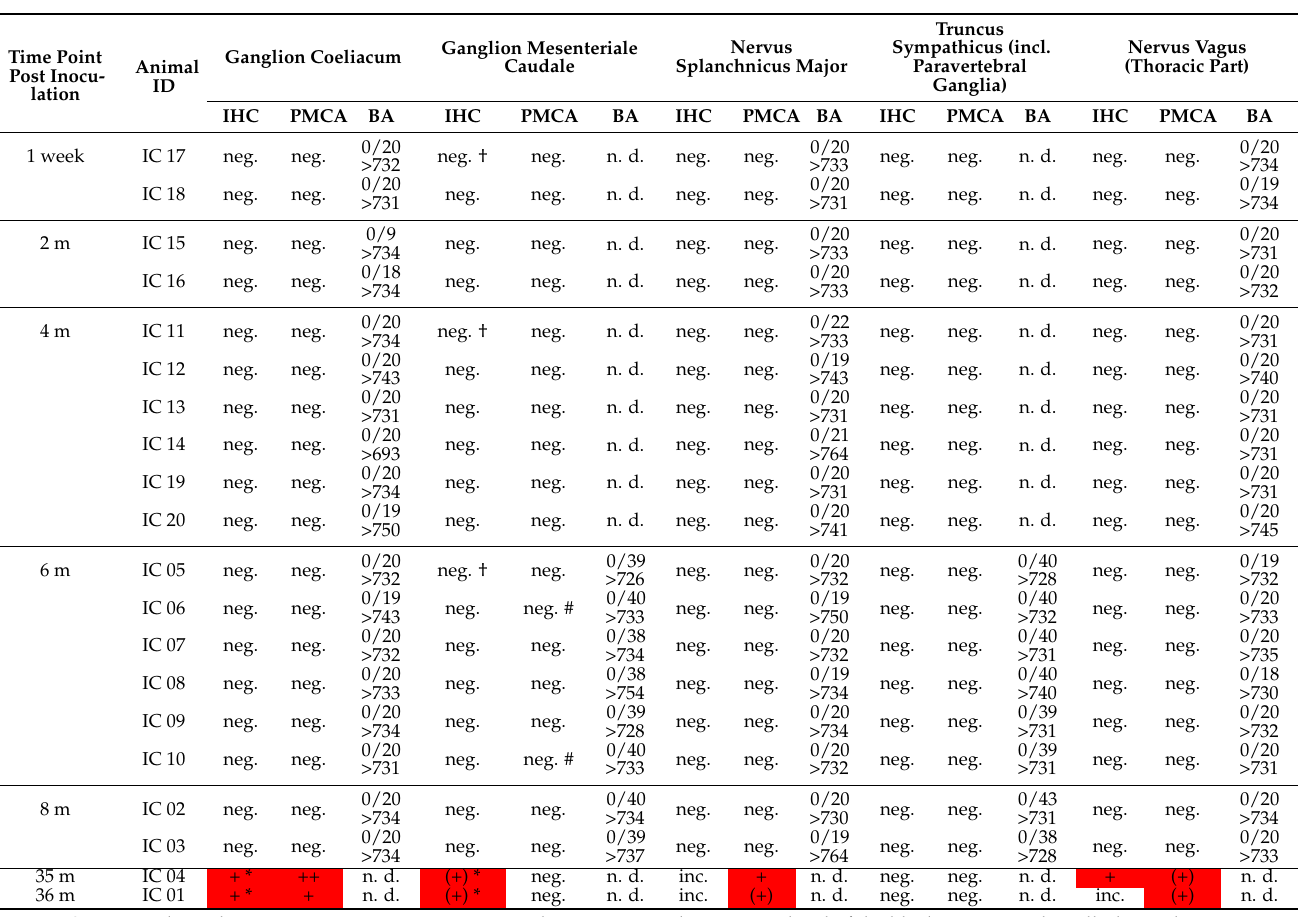
Table 1. Results for peripheral nervous tissues in the vicinity to the intestine were obtained by IHC, PMCA, and Tgbov XV mouse bioassay. Time Point Post Inocu-